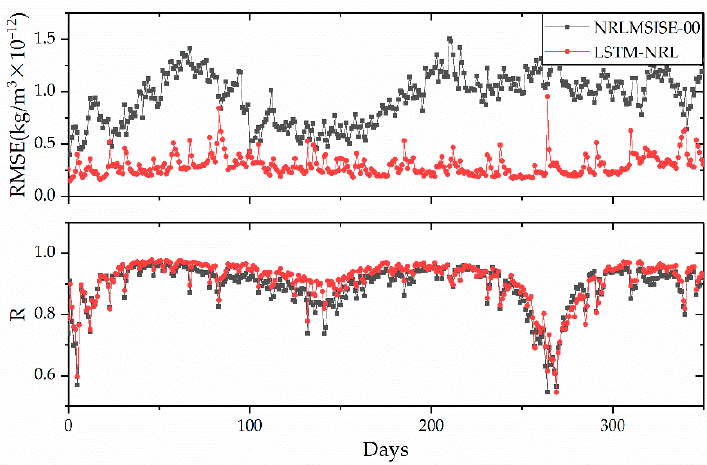
Figure 5. The daily RMSE and R over a year of Test 3.